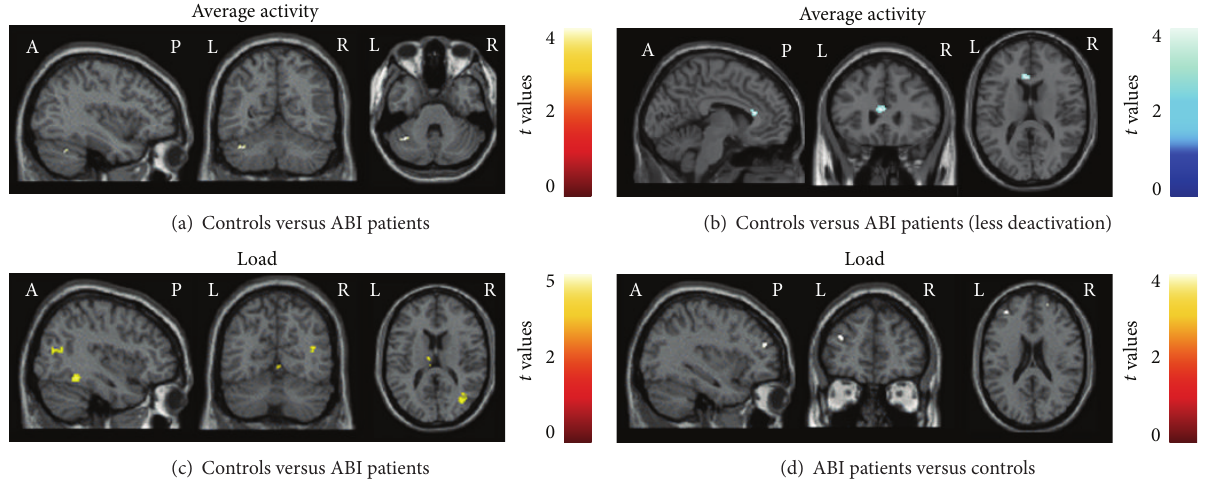
Figure 2: Brain regions showing significantly different fMRI activation during the modified Conners Continuous Performance Test (CCPT) between controls and patients with acquired brain injury (ABI). (a) and (b) Between-group differences during the average condition; (c) and (d) between-group differences during the load effect. Differences of activation are coded in red-yellow scales, whereas differences of deactivation are coded in blue-light blue scales. Results are shown at 𝑝 < 0.001 , uncorrected. Images are in neurological convention. See text for further details.